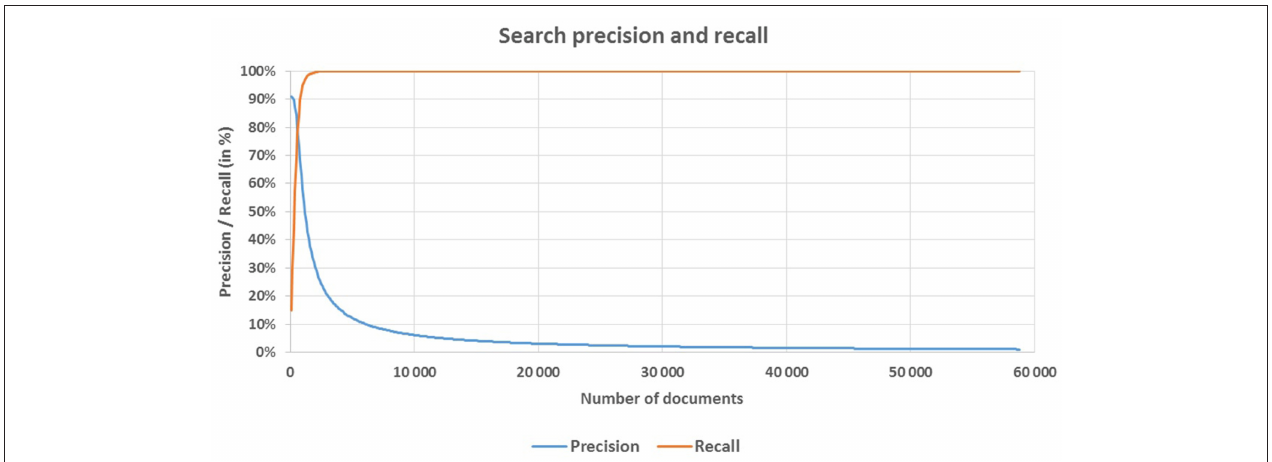
FIGURE 4 | Search precision and recall. Density of relevant documents in the set sorted by the relevance score decreases as the size of the set grows bigger. The more relevant documents are placed in the first thousand documents, the less are found in the second, etc. Therefore, search precision decreases monotonically toward the end of the selected set. For our task, this implies that only the first few thousand documents need to be analyzed where the density of relevant documents is nearing maximum. Nearly 99% of relevant documents are discovered within the first 2000 documents.